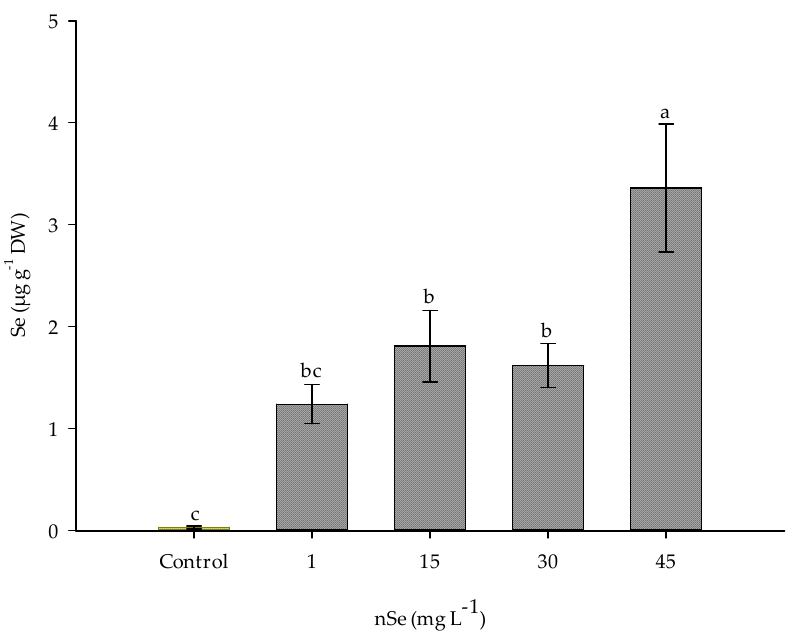
Figure 6. Se concentration in fruits of jalapeño pepper. DW: dry weigth. Different letters indicate differences between treatments (Tukey test p ≤ 0.05). n = 5 ± standard error.